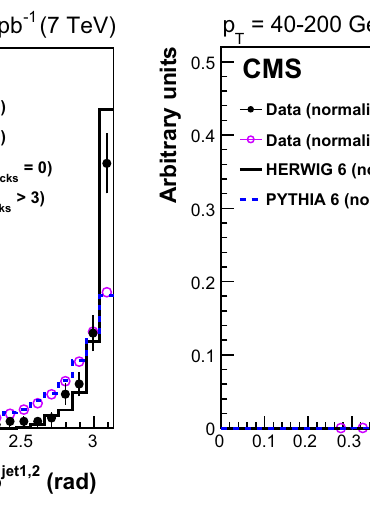
tracks ( N tracks > 3, open circles) reconstructed in the | η | < 1 region, / p jet1 compared with the MC predictions. The distributions are summed over T T the three p jet2 bins used in the analysis and normalized to unity for T shape